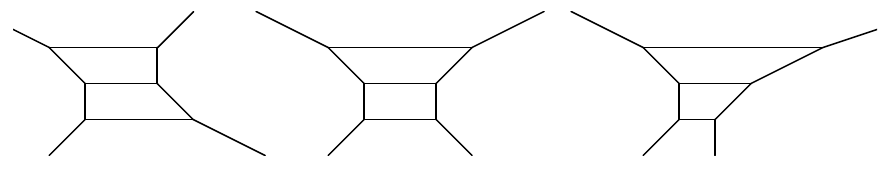
Figure 2 . 5-brane webs for the SU(3) κ =0 , 1 , 2 theories without